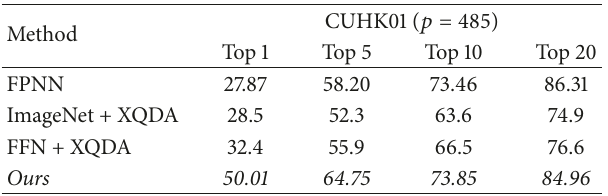
Table 9: Comparison of CNN-based algorithms results reported with CUHK01 database. The cumulative matching scores (%) at ranks 1, 5, 10, and 20 are